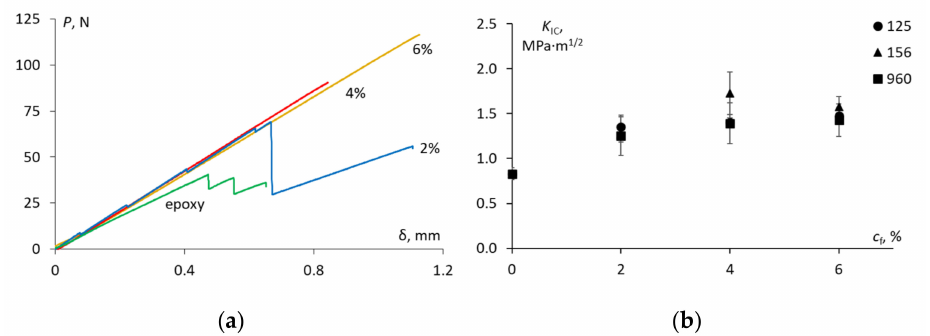
Figure 5. Load–displacement curves for TDCB tests of the epoxy and epoxy filled with ACE MX-960 at different filler weight fractions indicated on the graph ( a ) and fracture toughness for the epoxy and epoxy modified with ACE MX-125, 156 and 960 at different weight filler fractions (indicated on the graph) ( b